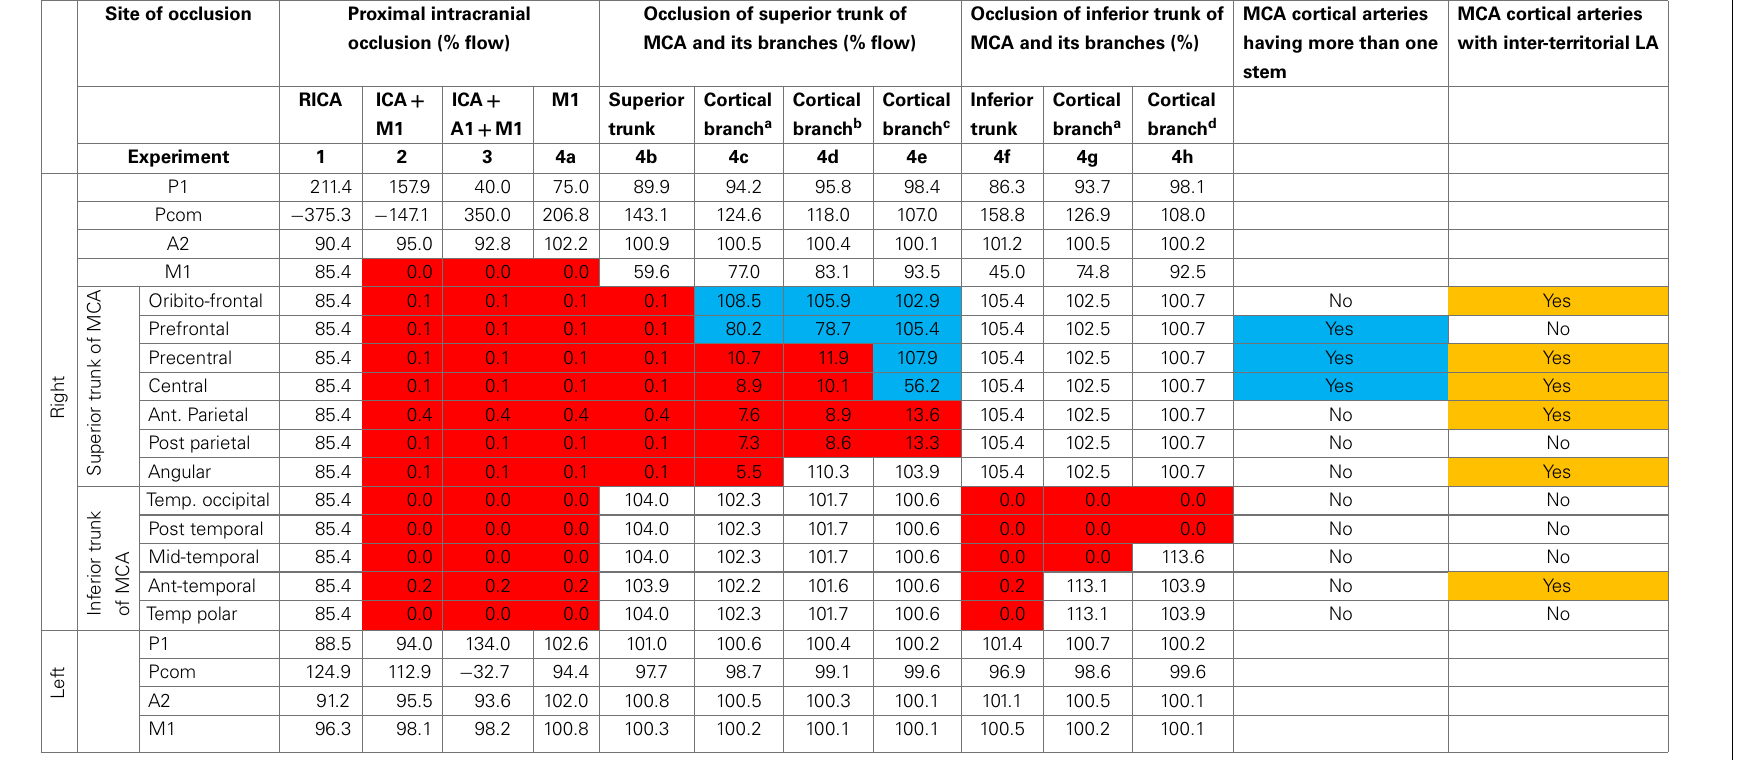
Table 2 | Effect of experimental occlusion. Intra-territorial LA = 2.0mm, inter-territorial LA = 0.25mm . Site of